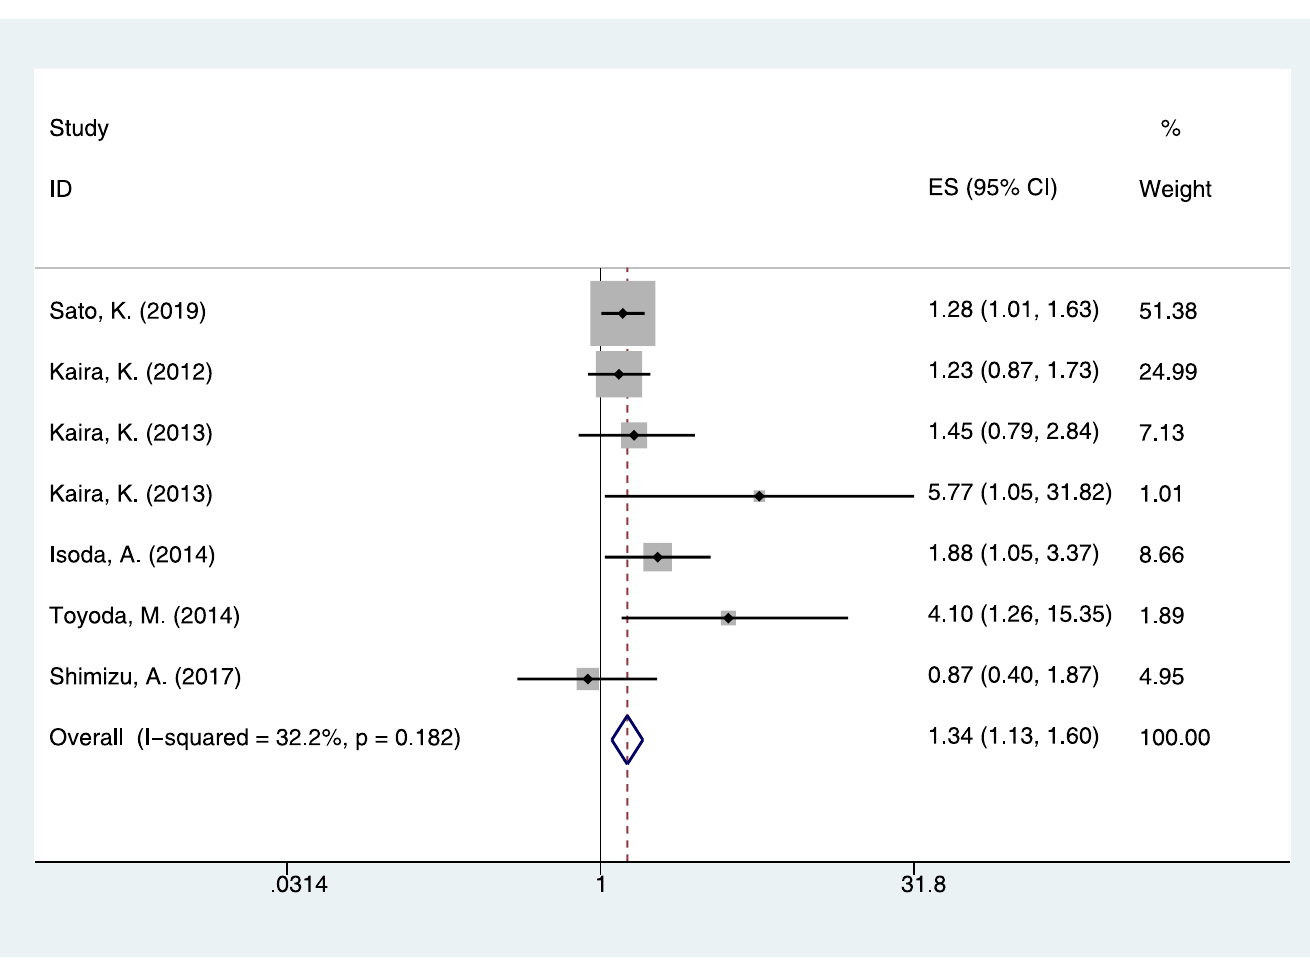
Fig 4. The correlation between LAT1 high expression and progression free survival